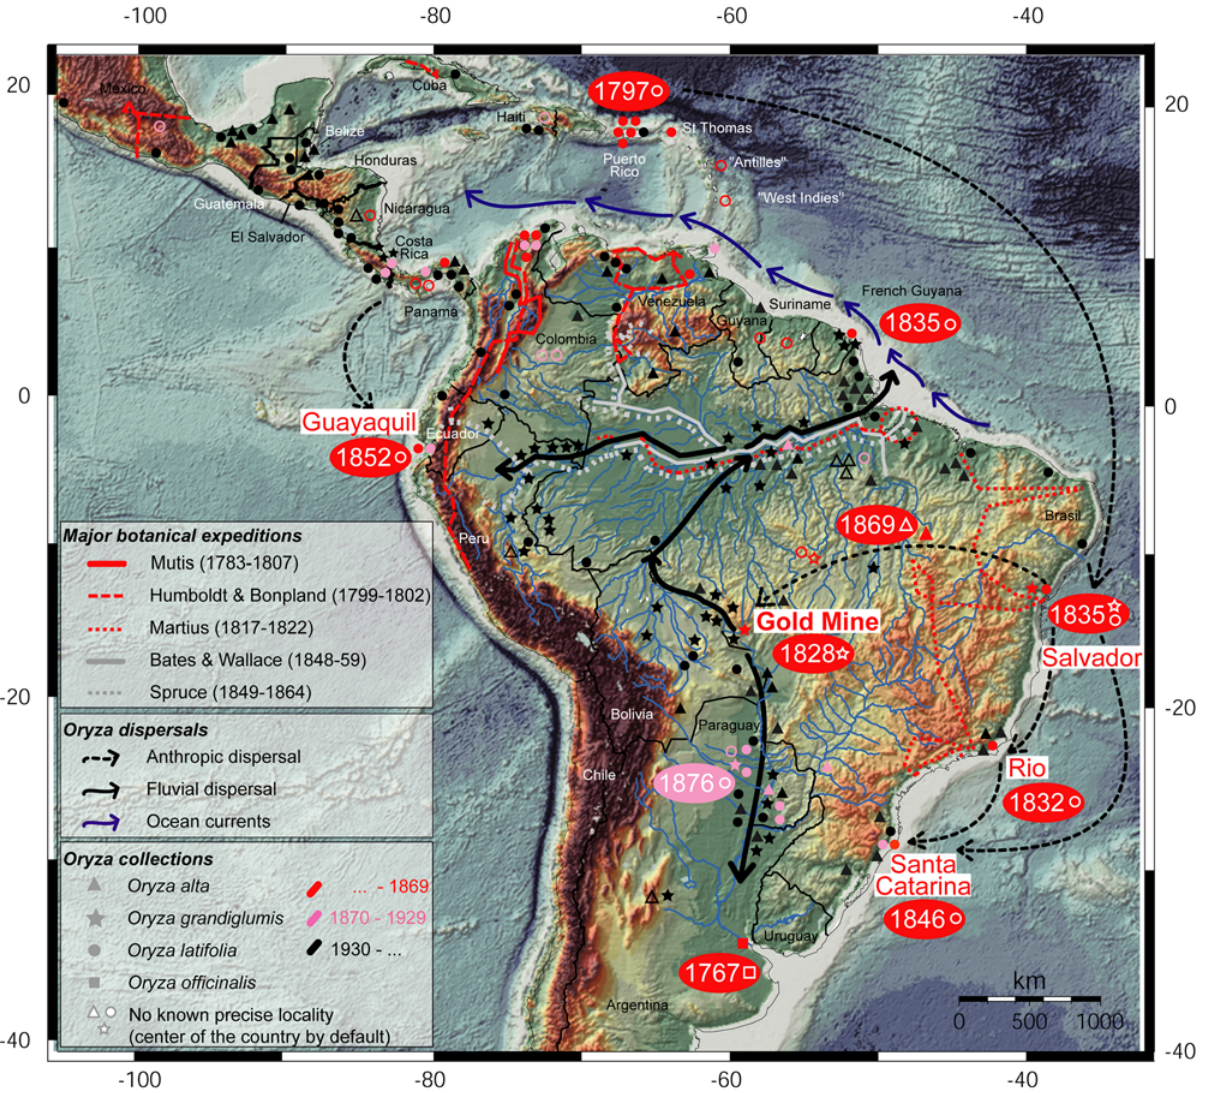
Figure 1. Distribution map of herbarium specimens in relation to time of collection and explorers routes. Summary of the original localization of all specimens determined as belonging to the ‘ O. officinalis complex’ recorded in our inventory of specimens from the 18 th century. All are thought to represent the CD genome, with the single exception of one specimen of O. officinalis (C genome). Three epochs are distinguished: 1/ until 1869, 2/ from 1870 to 1929, and 3/ after 1930. The three species with the CD genome ( O. alta , O. grandiglumis , and O. latifolia ) are distinguished, and the routes followed by major explorers who made collections or mentioned Oryza in their reports before 1869 are indicated. Also, key dates are reported for first collections at important sites or in major